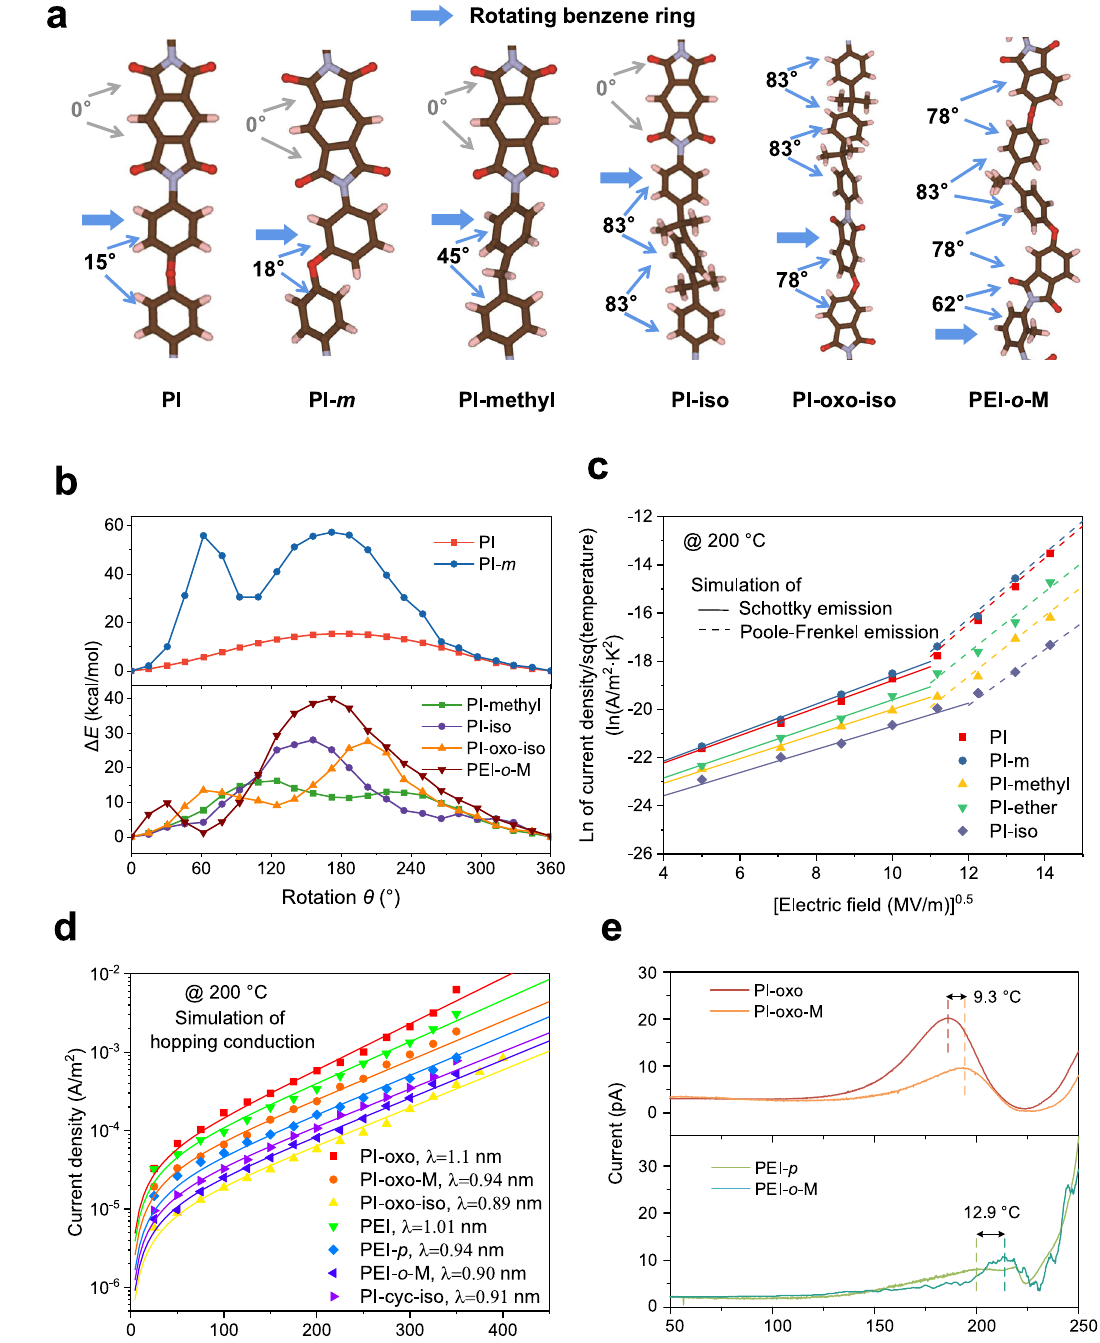
Fig.4|Chargetransportmechanism.a Schematicdiagramofsixpolymerchains atthe lowestenergy. b The rotationalenergy barrier of benzene ring asa function of rotation angle. c Current density of the PI-derived polymers synthesized from pyromelliticdianhydride asafunctionofelectric fi eldat200°C. d Currentdensity